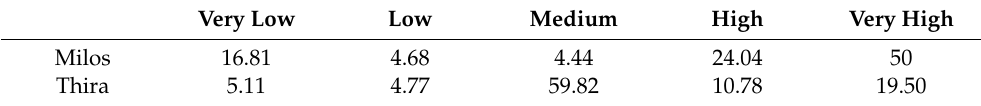
Table 7. Percentages of susceptibility classes to torrential flood in Milos and Thira islands. Very Low Low Medium